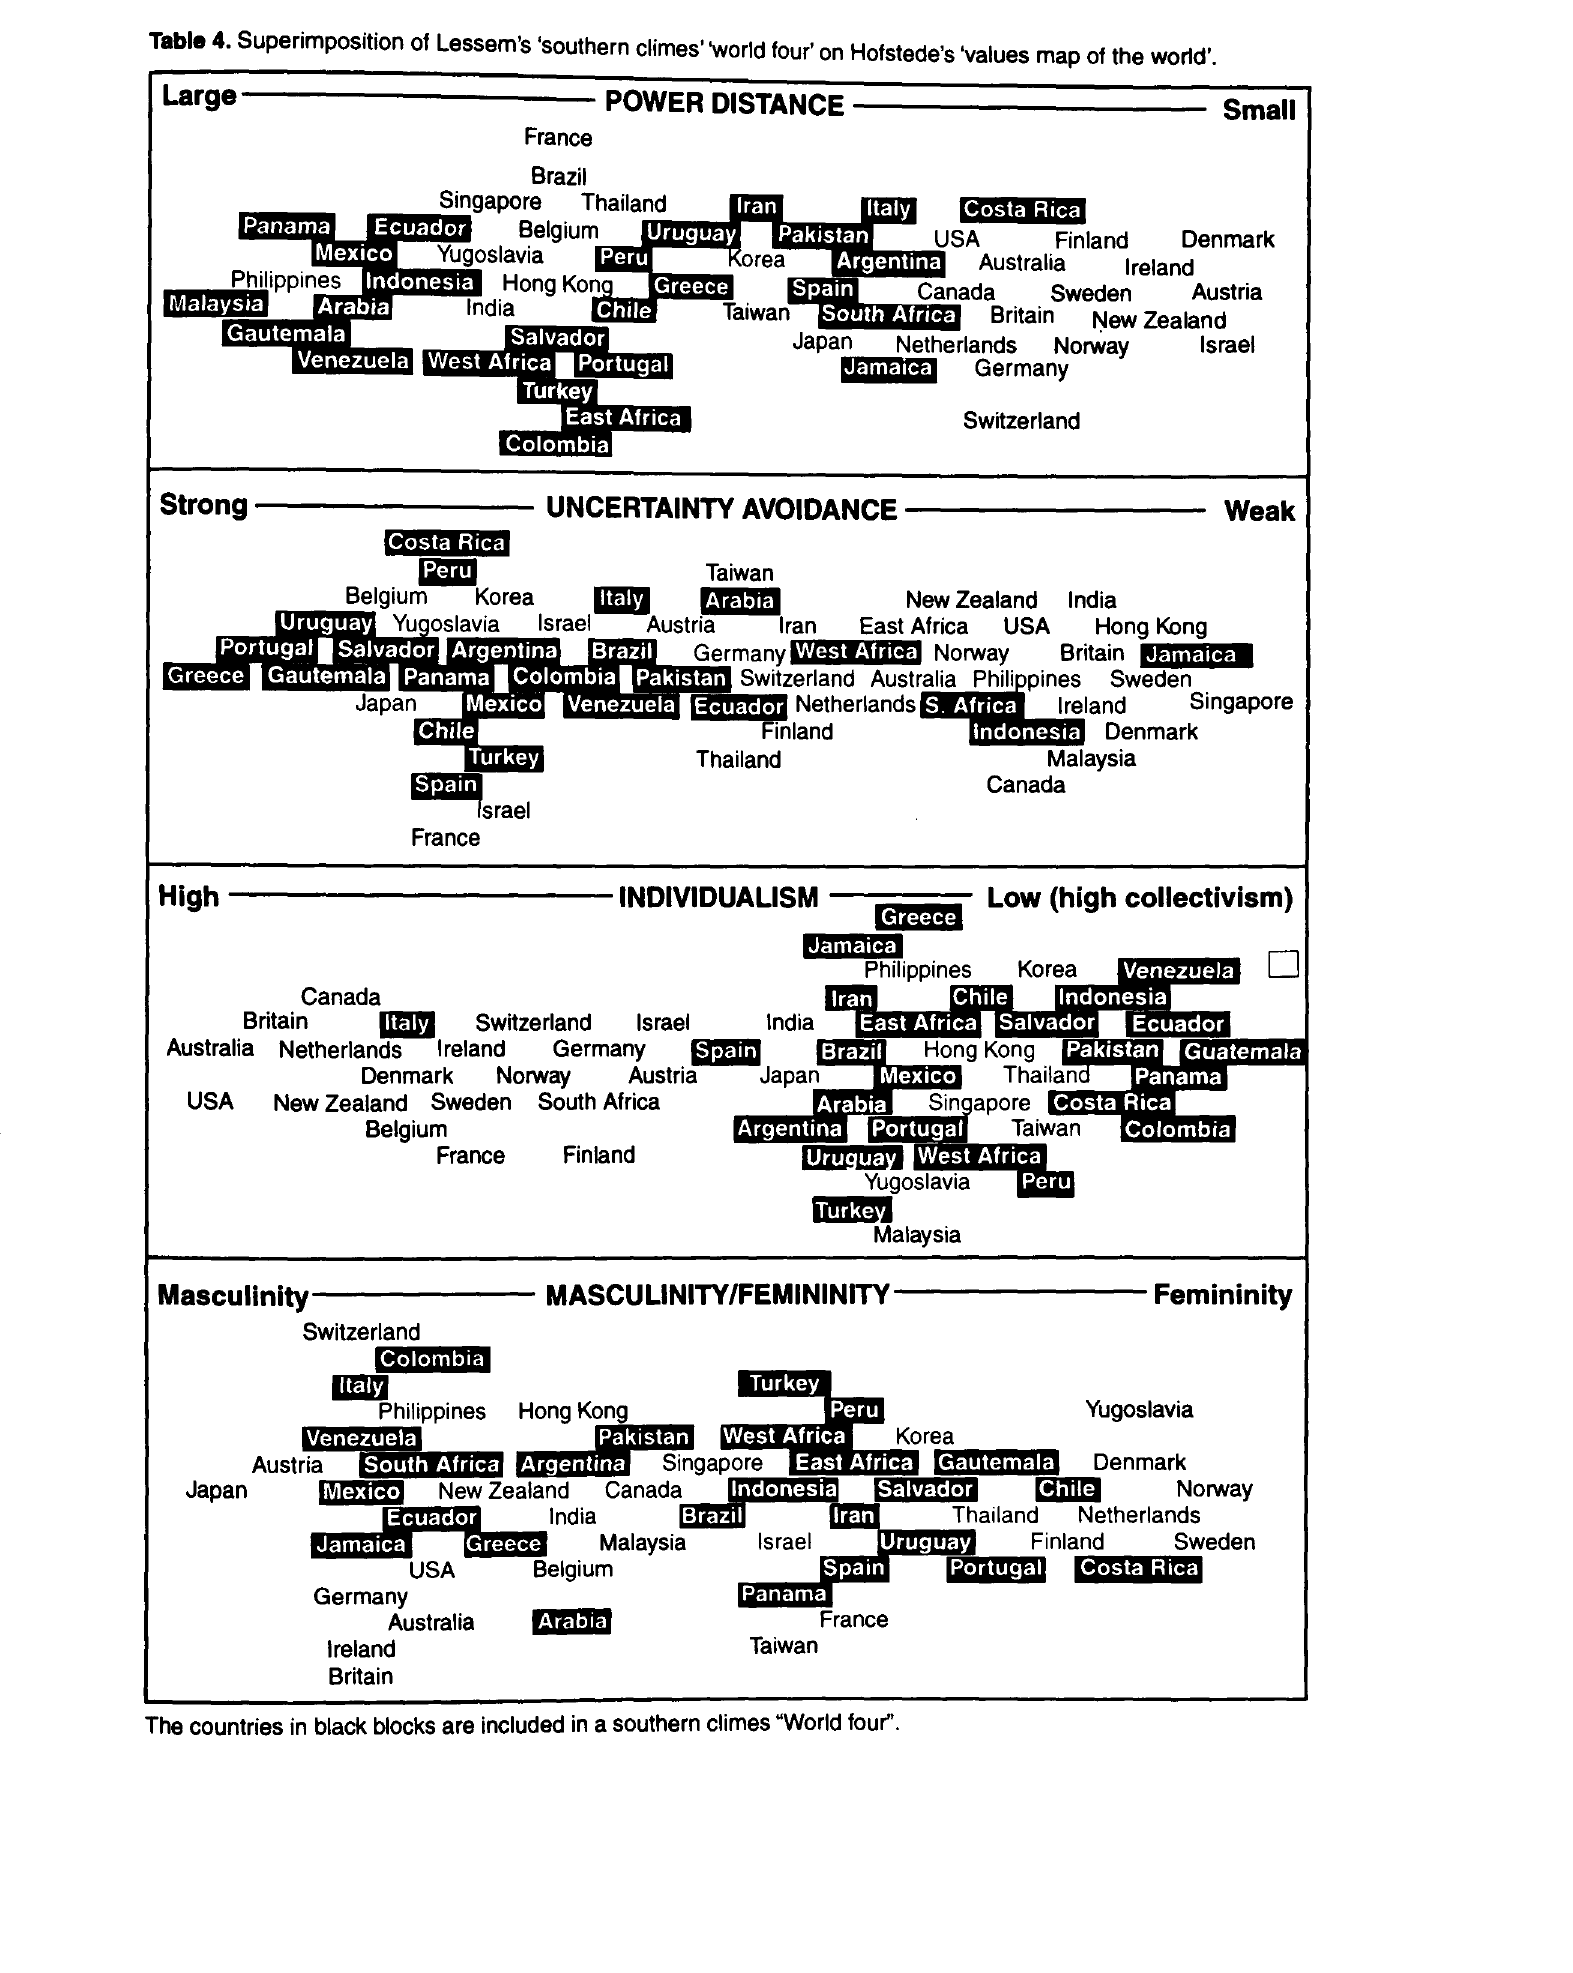
Table 4. Superimposition of Lessem's 'southern climes' 'world four' on Hofstede's 'values map of the world'.